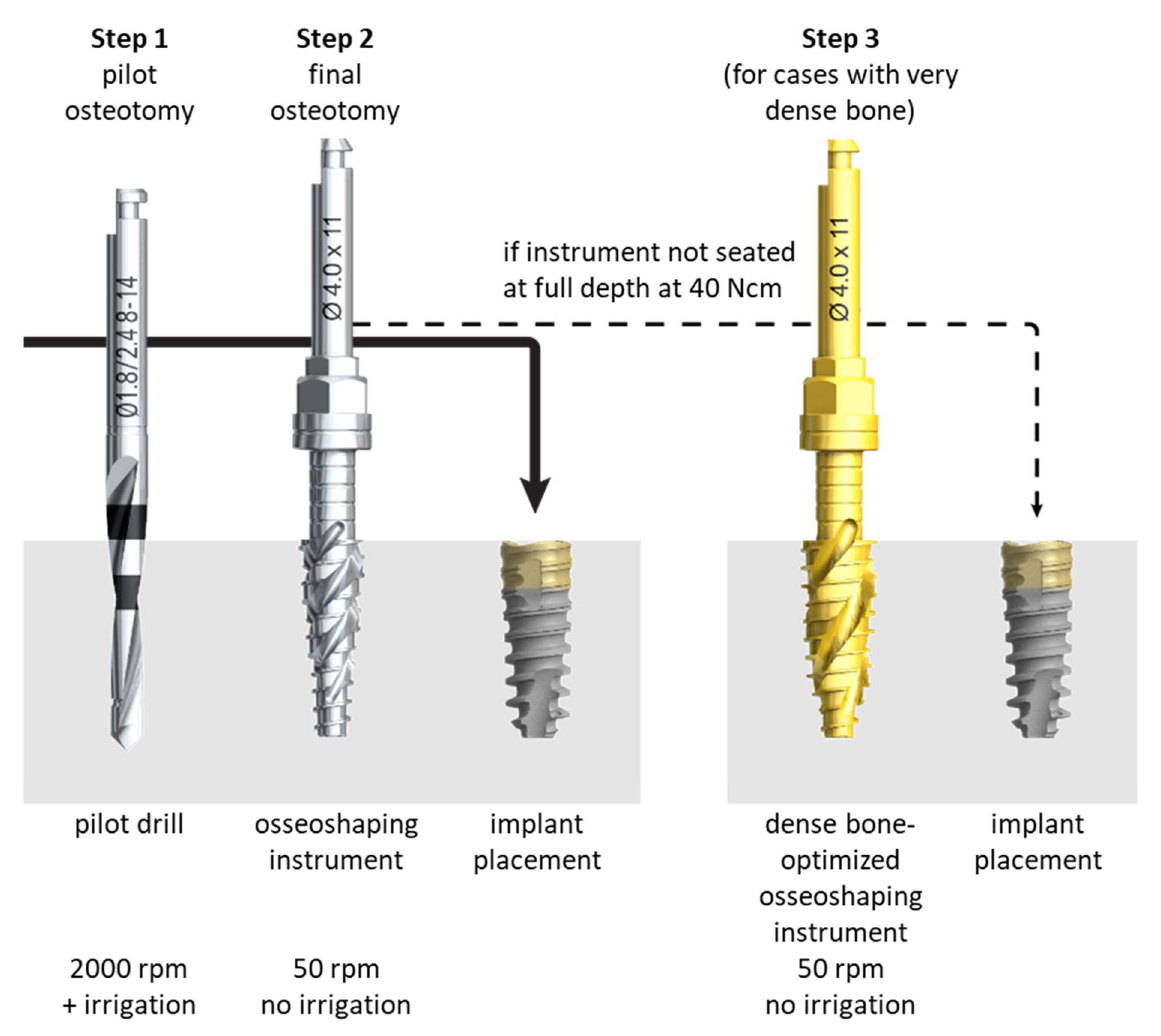
Figure 1. Osteotomy formation protocol. Implant placement follows a two-step site preparation in cases where the osseoshaping instrument can be fully seated without exceeding the torque of 40 Ncm ( left panel ). If the instrument cannot be seated, the osteotomy is further enlarged using the dense bone–optimized osseoshaping instrument using a torque of up to 40 Ncm ( right panel ). If needed, the dense bone drill is used (not shown).